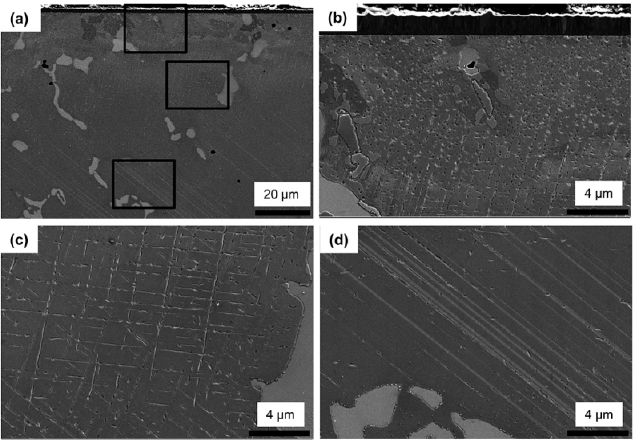
Figure 6. Low- (1000 × , ( a )) and higher- (5000 × , ( b – d )) magnification cross-sectional SEM micrographs ( a ) showing the CVD TiN coating layer and Co–Cr alloy substrate: approximately 12 µ m ( b ), approximately 16 to 36 µ m ( c ), and approximately 53 to 73 µ m ( d ) from the coating interface.